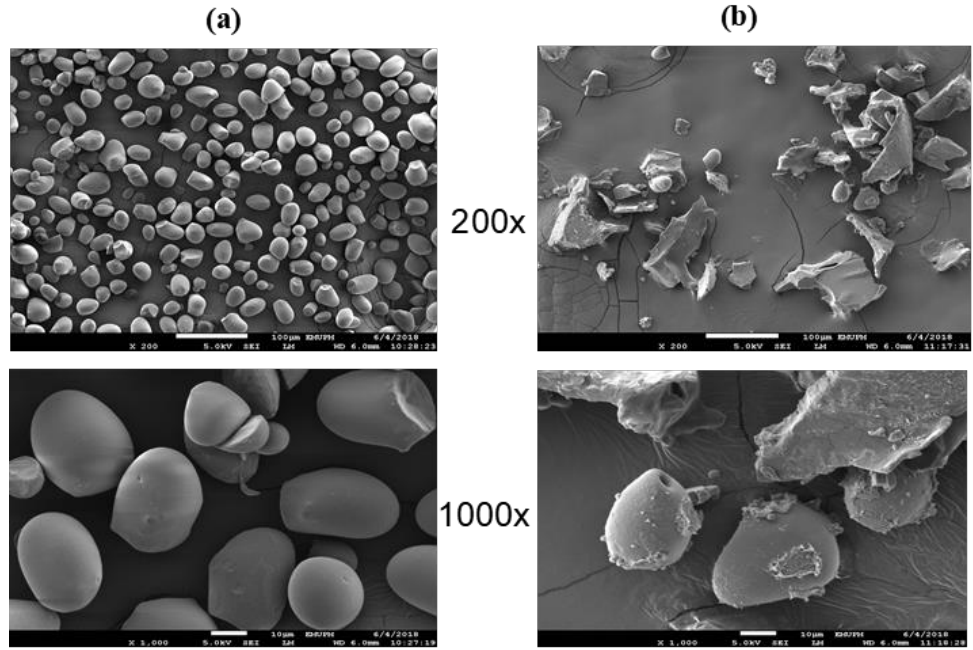
Figure 7. Field emission scanning electron micrograph of ( a ) sago starch, and ( b ) cationic sago starch with DS 1.195 at ×200 and ×1000 magnification.